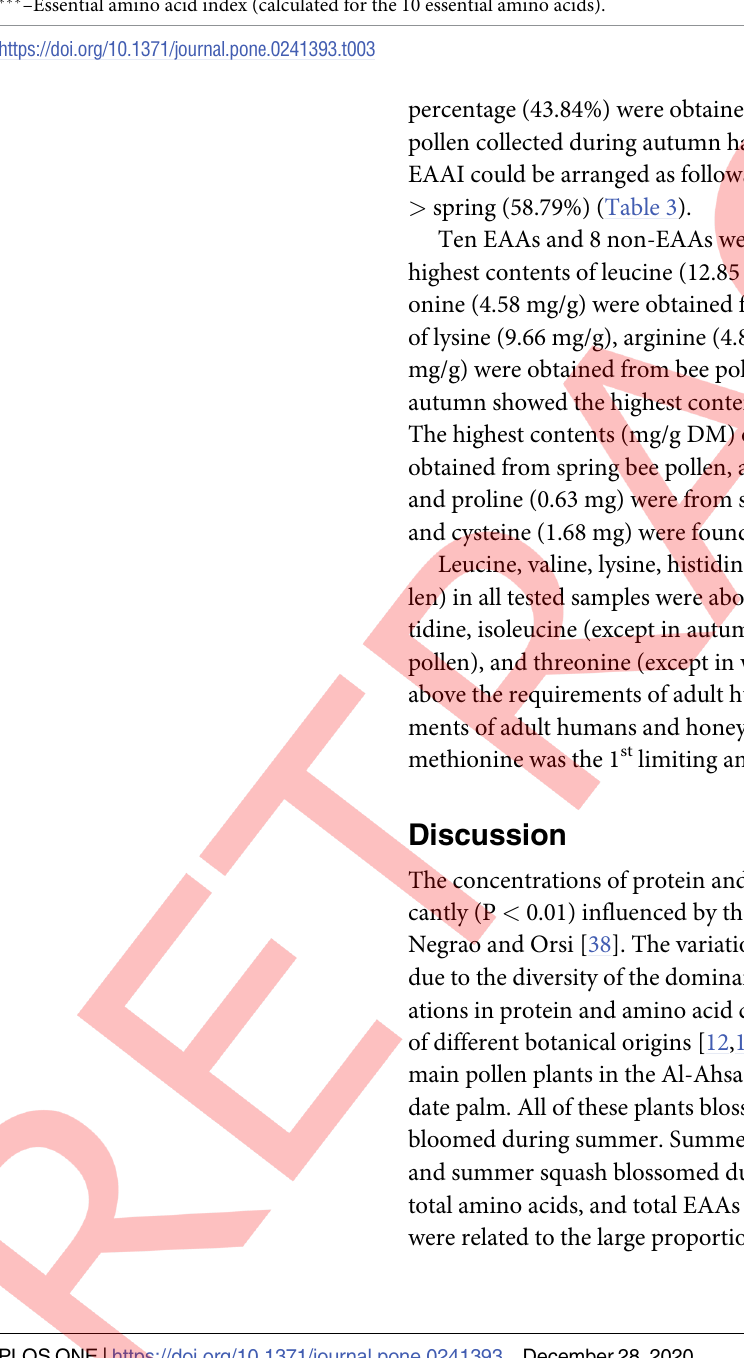
Values are the mean ± standard deviation. Means of each column followed by a different letter are significantly different at the 0.01 level. � –Total amino acids �� –Total essential amino